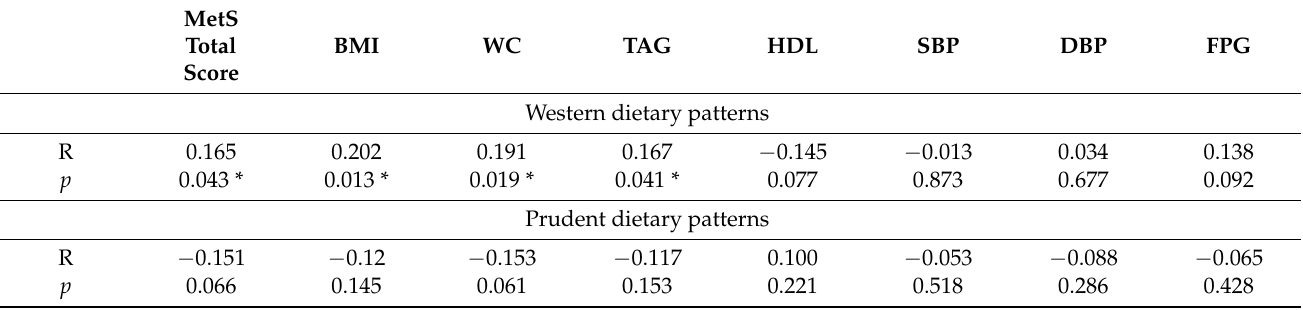
Table 3. Correlations of dietary patterns with MetS and cardiometabolic risk factors.